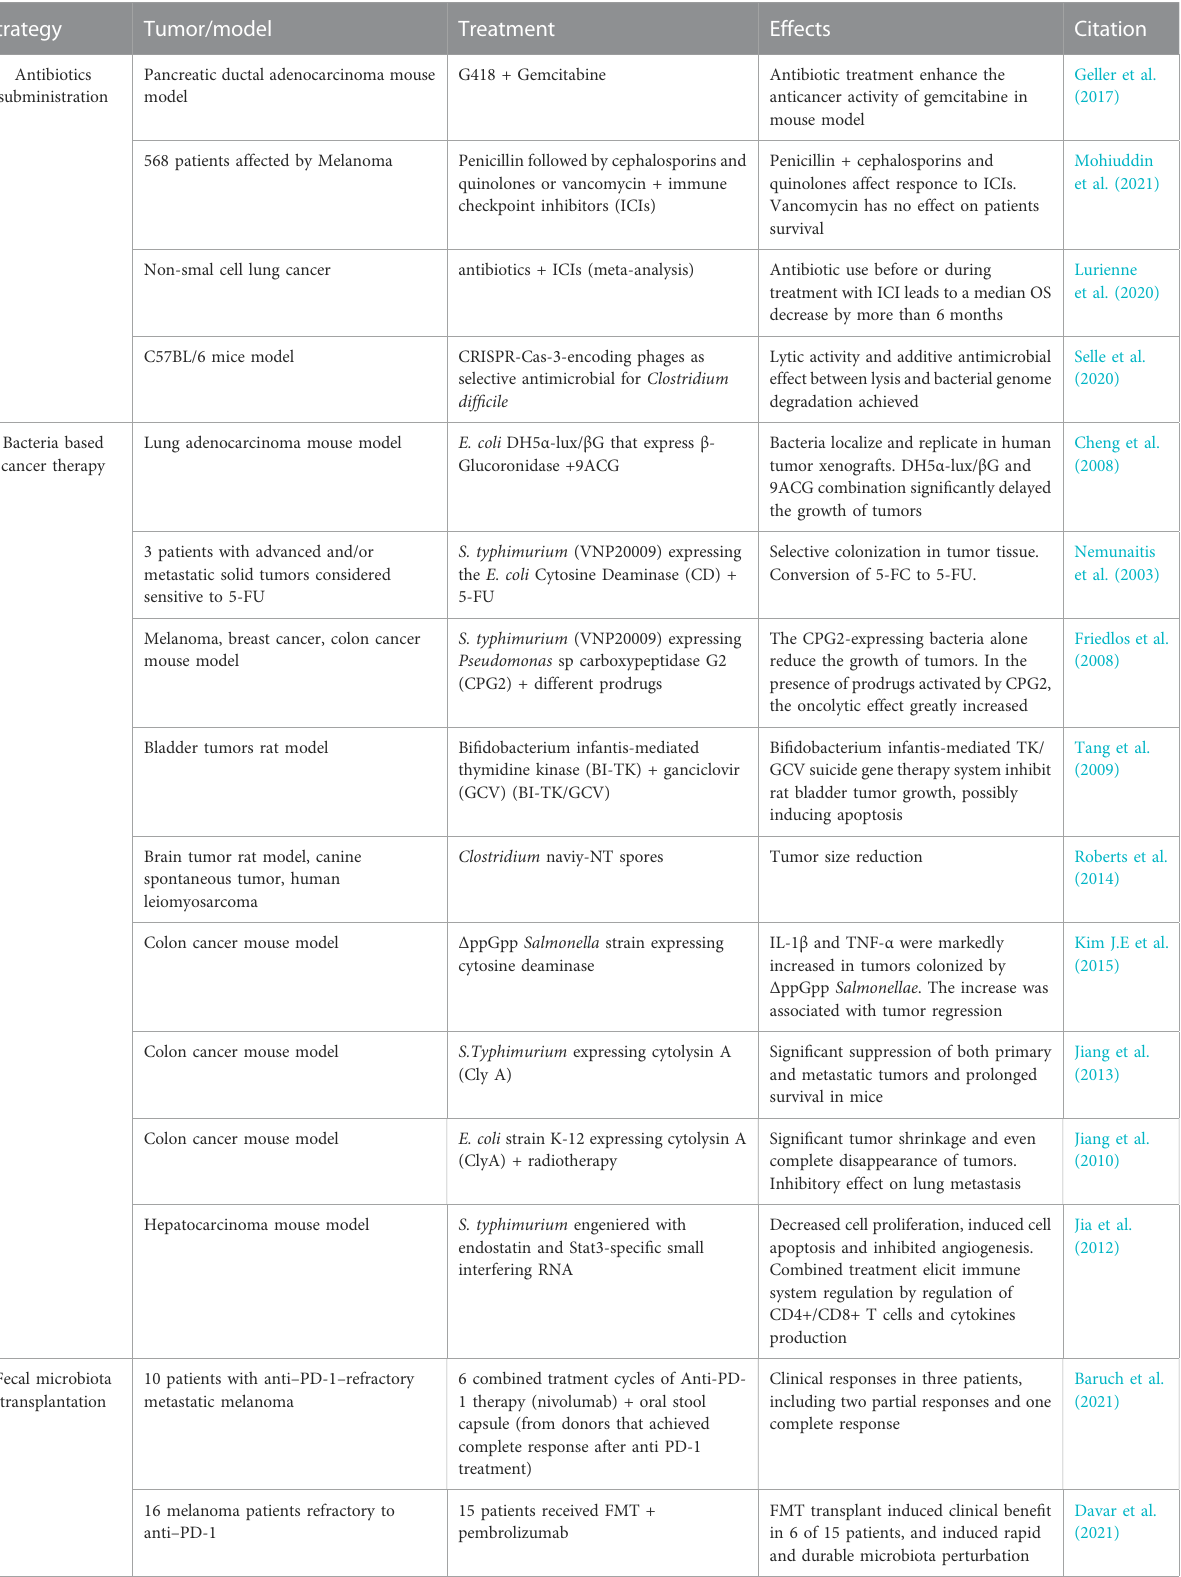
TABLE 1 Summary table of all the microbiota manipulation methods reported in the